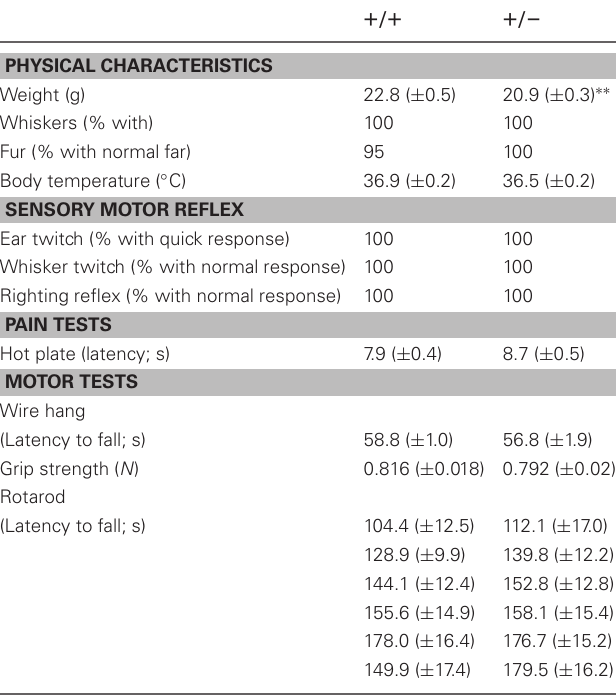
Table 2 | General health, neurological reflexes, and sensory and motor abilities in Apc + / − mice ( + / − ) and wild-type littermate controls ( + / +